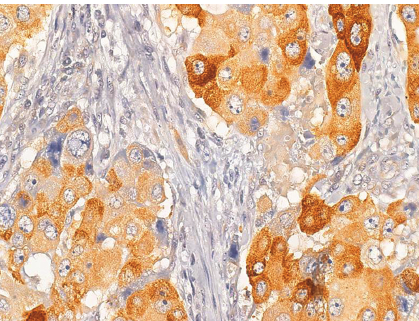
F 7: (Original magni�cation 100�). Fibrolamellar carcinomas